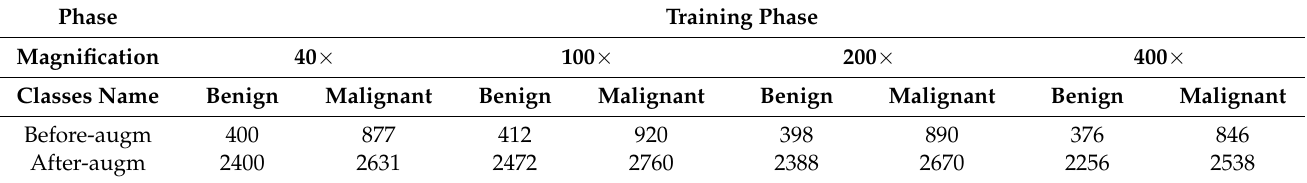
Table 3. Data augmentation method to balance the dataset during the training